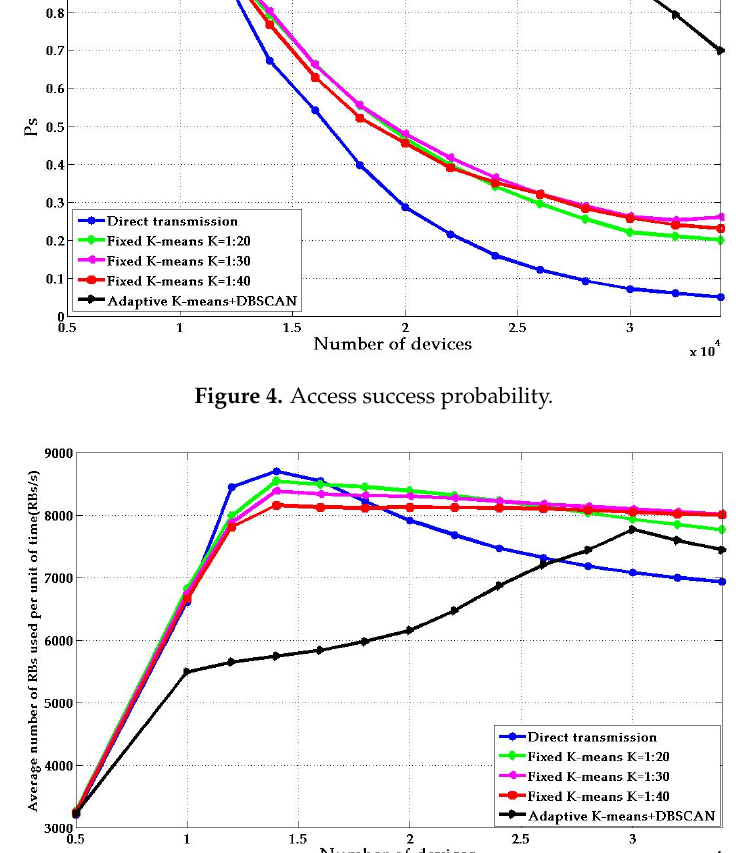
Figure 6. Average transmitted data amount per unit RB.